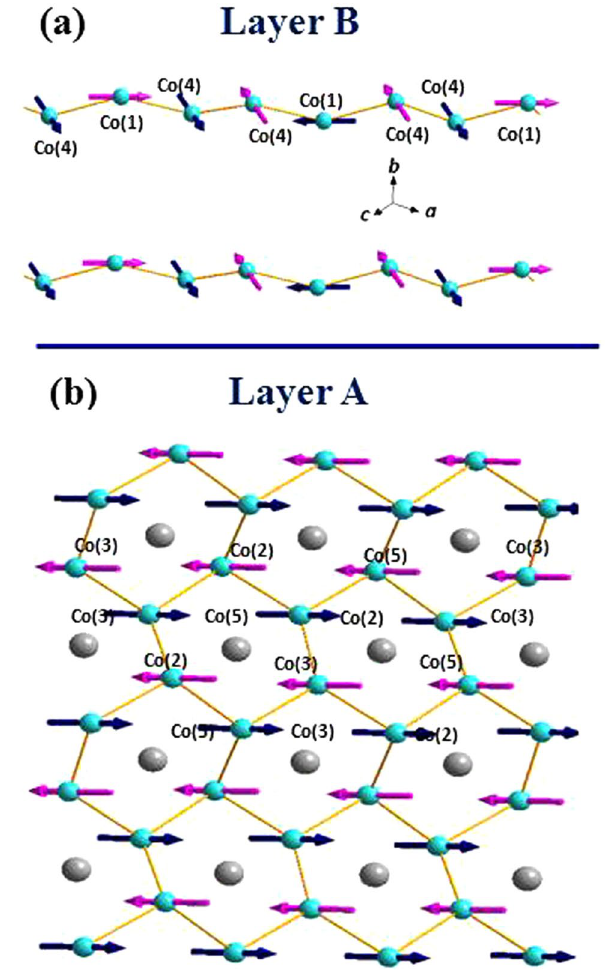
Figure 3. Schematic drawing of the Co spin arrangements in ( a ) Layer B and ( b ) Layer A. The Co spins in the wavy honeycomb web form a simple antiferromagnetic arrangement; whereas those in the zigzag chains form a non-collinear spin arrangement. The moments of all Co ions lie in the crystallographic a - c